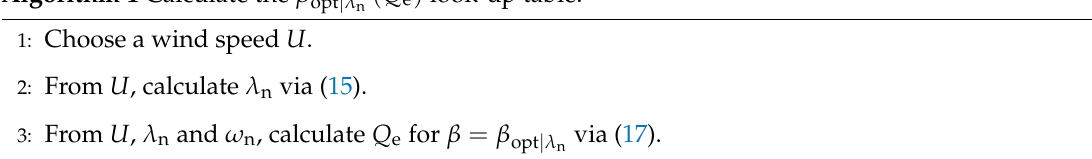
Figure 5. Optimal minimum pitch angle as a function of generator torque for NREL 5-MW ( a ) and DTU-10 MW ( b ) reference turbines. ( Q ) look-up Algorithm 1 Calculate the β e opt | λ n